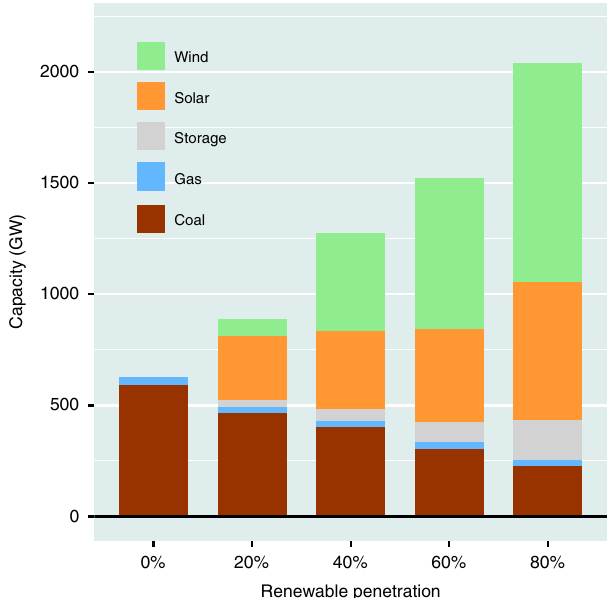
Fig. 4 National generation mix. Country-wide generation mix of capacities (GW) for different levels of renewables identi fi ed using the optimization model with parameters appropriate for the standard